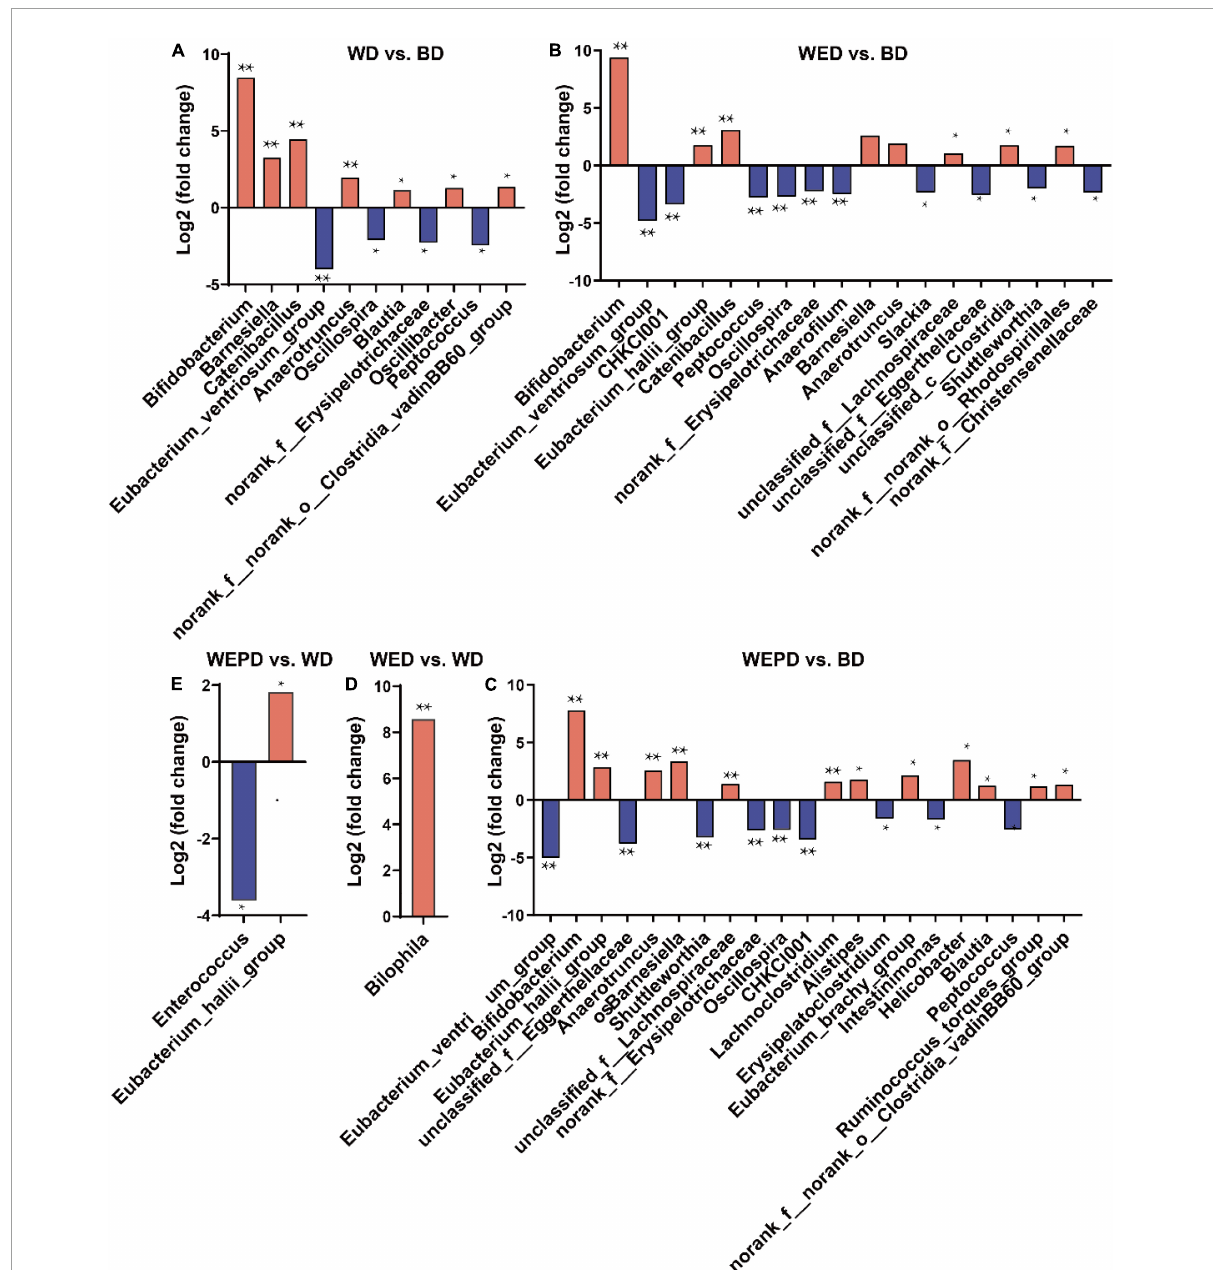
FIGURE4 Differential genera analysis of cecum microbiota. (A) Pairwise comparisons between WD and BD groups using the DESeq2 method. Positive fold changes mean the genus is enriched in the WD group, while negative fold changes mean those enriched in the BD group. (B) Pairwise comparisons between WED and BD groups. (C) Pairwise comparisons between WEPD and BD groups. (D) Pairwise comparisons between WED and WD groups. (E) Pairwise comparisons between WEPD and WD groups. * P -value (FDR) < 0.05; ** P -value (FDR) <